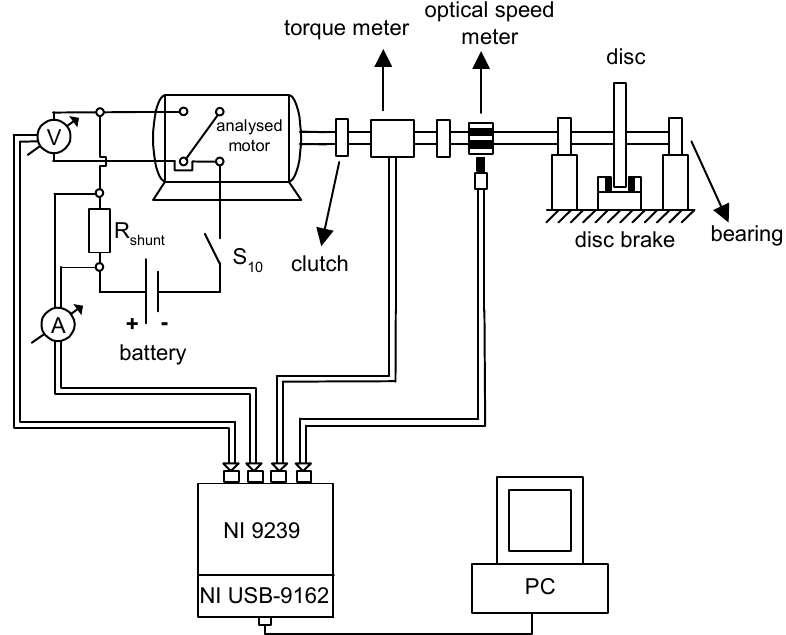
Figure 19. Experimental setup for static and dynamic test measurements.